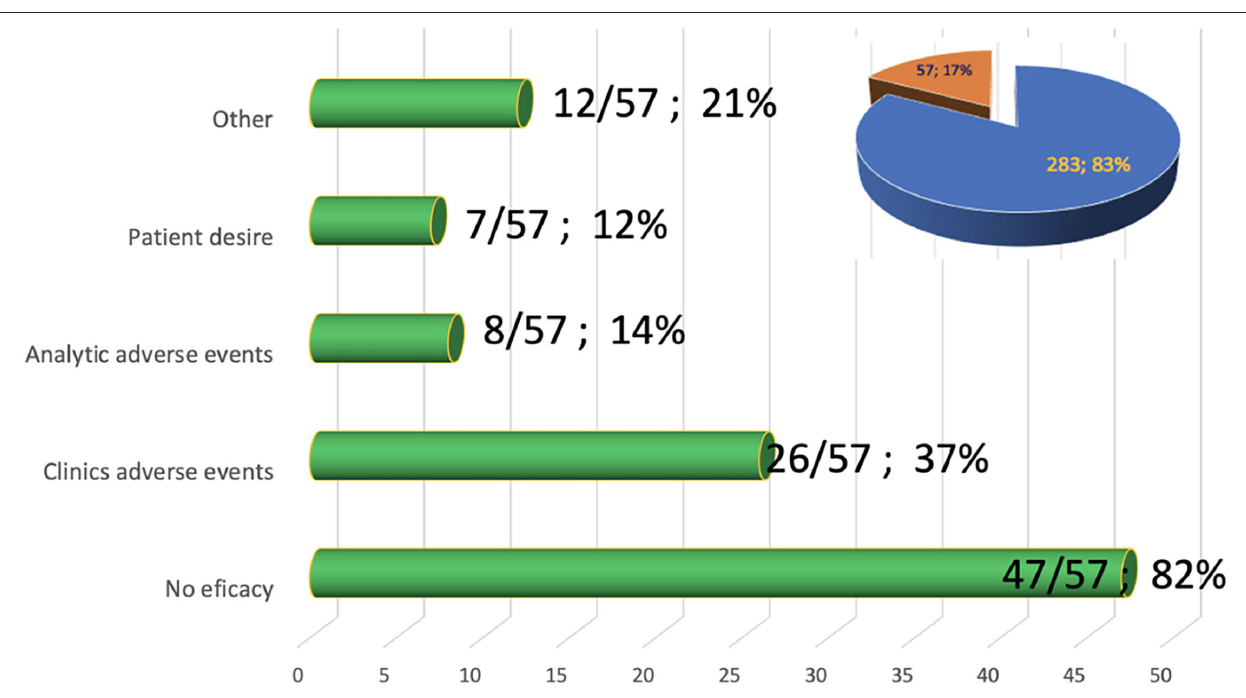
FIGURE 7 | Causes of withdrawal from Teriflunomide treatment. Sector diagram shows the % of patients still being treated with Teriflunomide